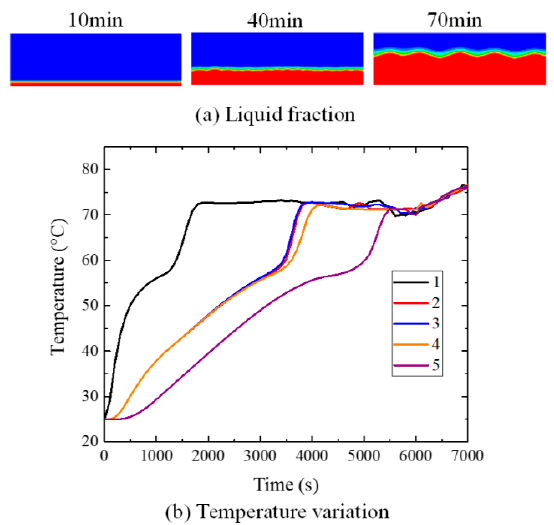
Figure 9. The melting process of paraffin at 0°. ( a ) Liquid fraction; ( b ) temperature variation.